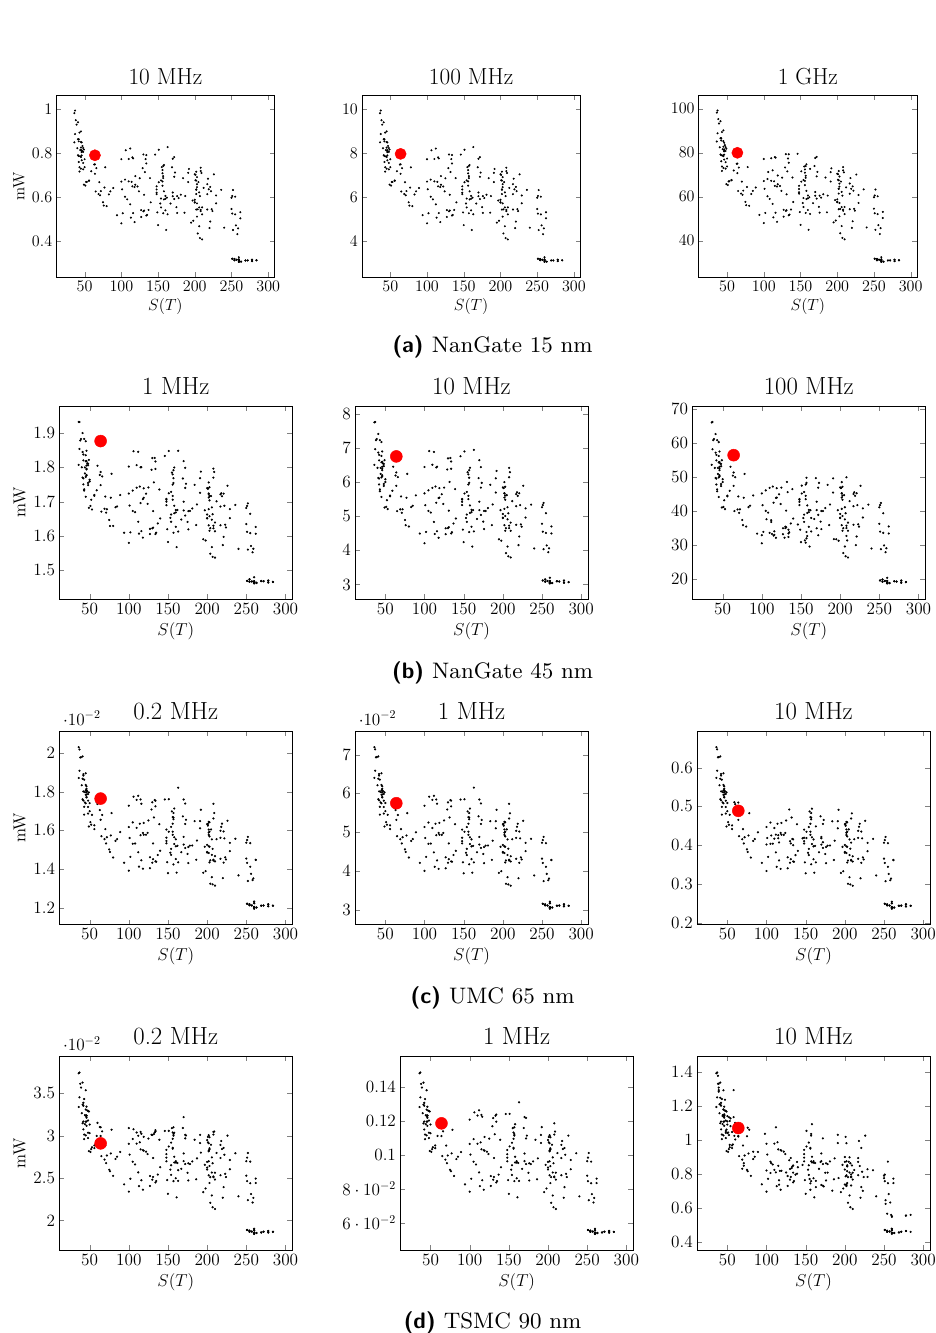
Figure 20: Power trees Grain-128